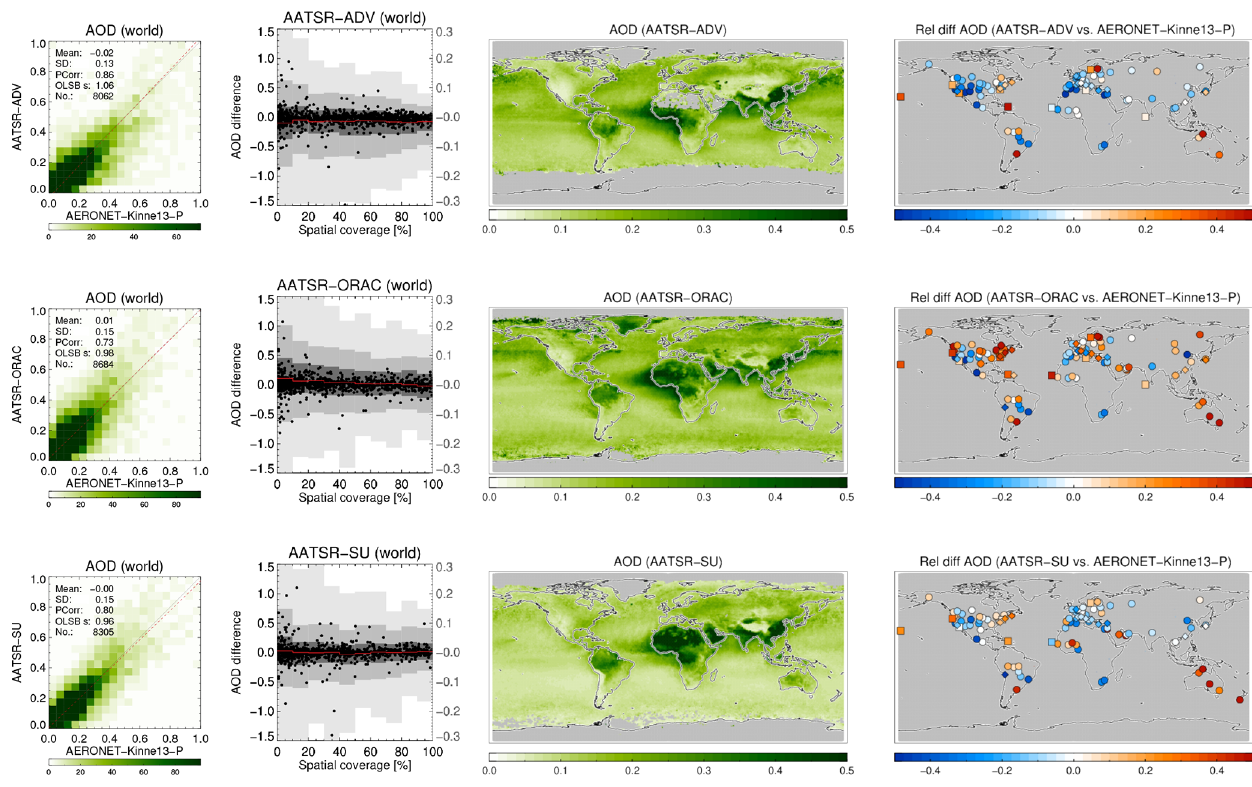
Figure 12. Same as Fig. 9, for AATSR products.